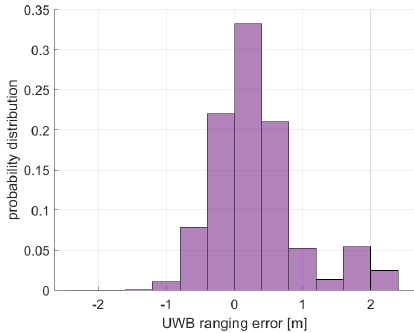
Figure 6. V2V Pozyx ranging error (left network) Figure 4. Example of V2V Pozyx range measurements: GPSVan-Toyota ranging compared with GNSS-reference distance.